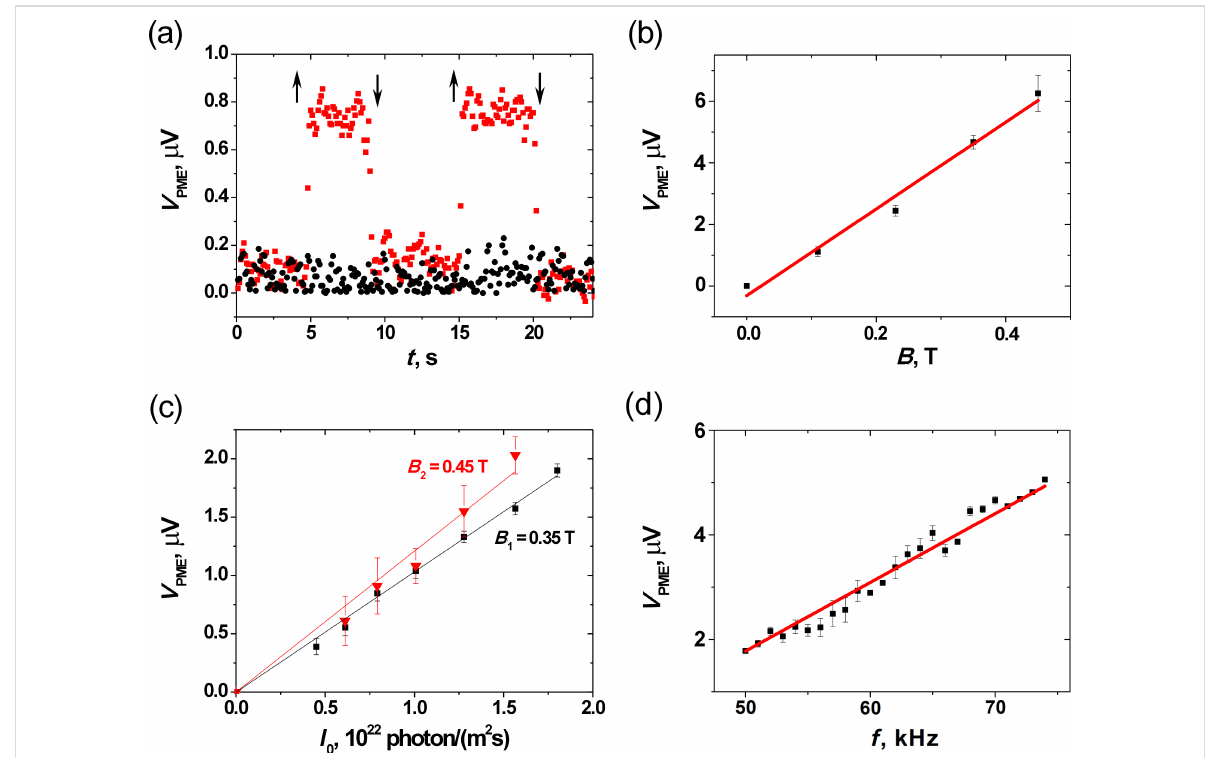
Figure 5: Voltage response in PME contactless investigations of graphene: (a) the time dependence for different values of magnetic field (black circles – B = 0; red squares – B = 0.45 T; I = 7.5·10 21 photons/(m 2 s); f = 72 kHz; ↑ and ↓ – represent switch on and switch off points of sinusoidally modulated illumination); (b) dependence on magnetic field induction ( I = 2.6·10 22 photons/(m 2 s); f = 72 kHz); (c) dependence on illumination intensity for varying magnetic field (black squares – B = 0.35 T; red triangles – B = 0.45 T; f = 72 kHz ); (d) dependence on frequency of illumination chopping ( I = 2.6·10 22 photons/(m 2 s); B = 0.45 T); symbols – the experimental data; solid lines – linear dependences calculated for the best fitted